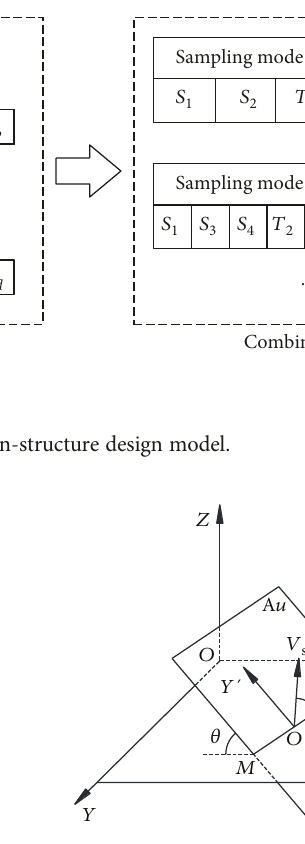
Figure 4: Auxiliary coordinate system for the motion module.